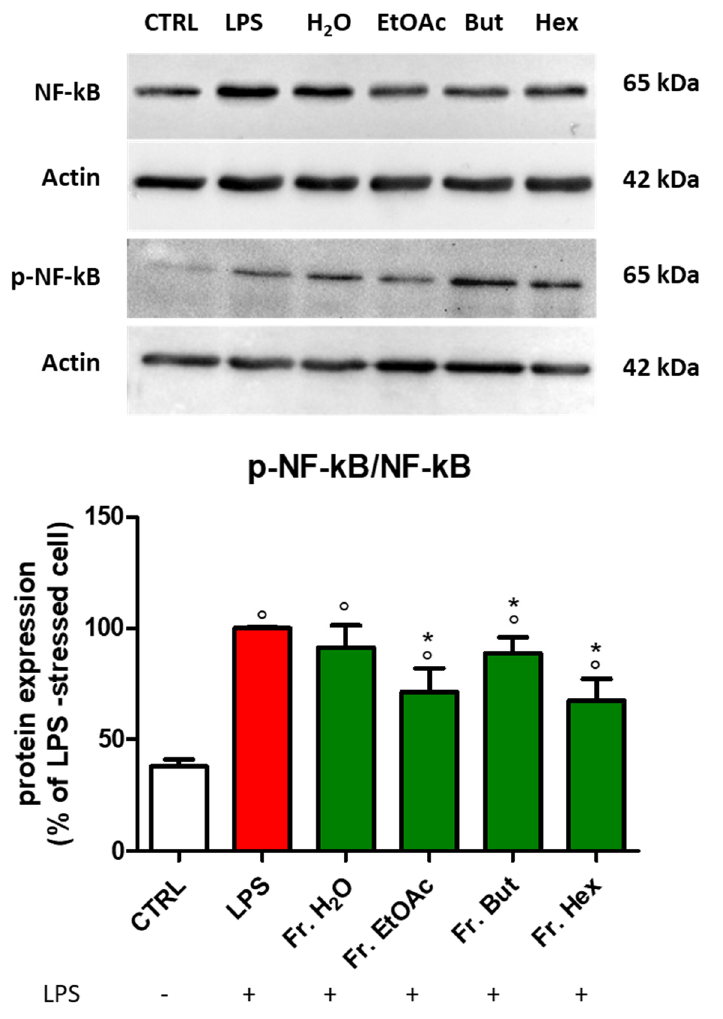
Figure 10. NF-kB and p-NF-kB protein expression in LPS-stimulated BV-2 cells treated with different chestnut leaf extract fractions. BV-2 cells were treated for 3 h with 50 µ g/mL of fractions at different polarities obtained from L, then stimulated (or not) with 0.5 µ g/mL LPS for 24 h. After cell lysis, the extracted proteins were separated by SDS-PAGE, transferred to a nitrocellulose membrane, and immunoassayed using anti-NF-kB or anti-p-NF-kB and anti-actin antibodies, as reported in the Materials and Methods section. Immunoblots are representative of three independent experiments; bars represent the densitometric analysis of immunoblotting results. Normalised expression levels were calculated relative to LPS-treated cells (red bars). Results are expressed as means ± SEM. Statistical analysis was performed by Fisher’s LSD test following one-way ANOVA. ° p < 0.05 significantly different from control cells; * p < 0.05 significantly different from LPS-treated cells.